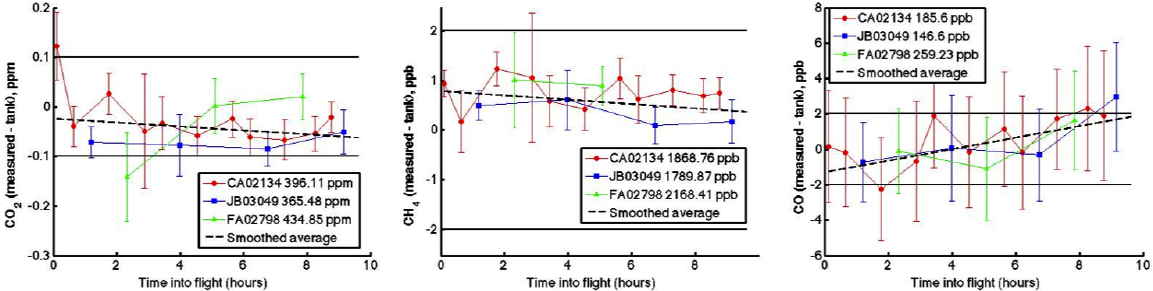
Fig. 6. Residuals of reference gas measurements for CO 2 (left), CH 4 (middle), and CO (right), during a flight on 4 April 2011. Different colors represent the different tanks, while the dashed black line is a linear fit with time to all the residuals. The dashed line is used to correct the sample mole fractions. Error bars are the standard deviation (1s) of the 0.5-Hz measurements of the standard gas during the 2-min averaging time. Solid black lines represent the WMO compatibility goals.